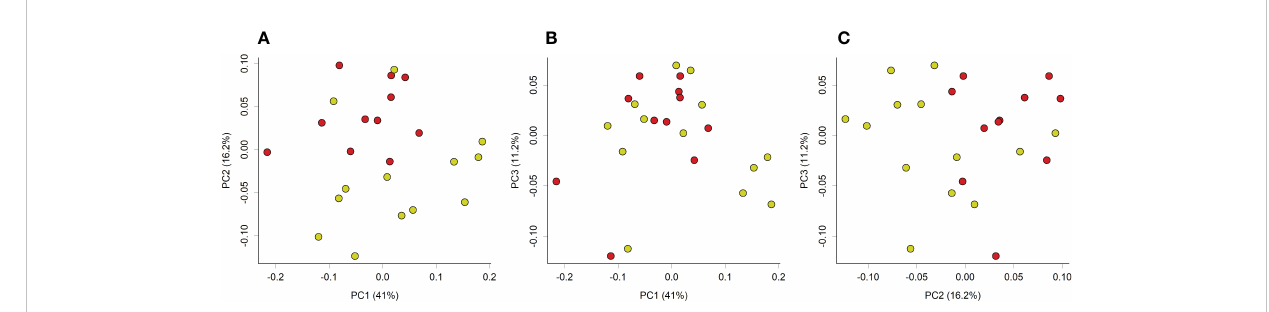
FIGURE 2 Principal coordinate analysis (PCoA) plot of weighted unifrac phylogenetic distances of caecal microbiotas from control (yellow) or loperamide (red) groups. Plots show (A) PC1 vs PC2, (B) PC1 vs PC3, and (C) PC2 vs PC3. Percentages on axes indicate proportion of variation explained by each dimension. Communities between groups were signi fi cantly different (PERMANOVA P=0.008).